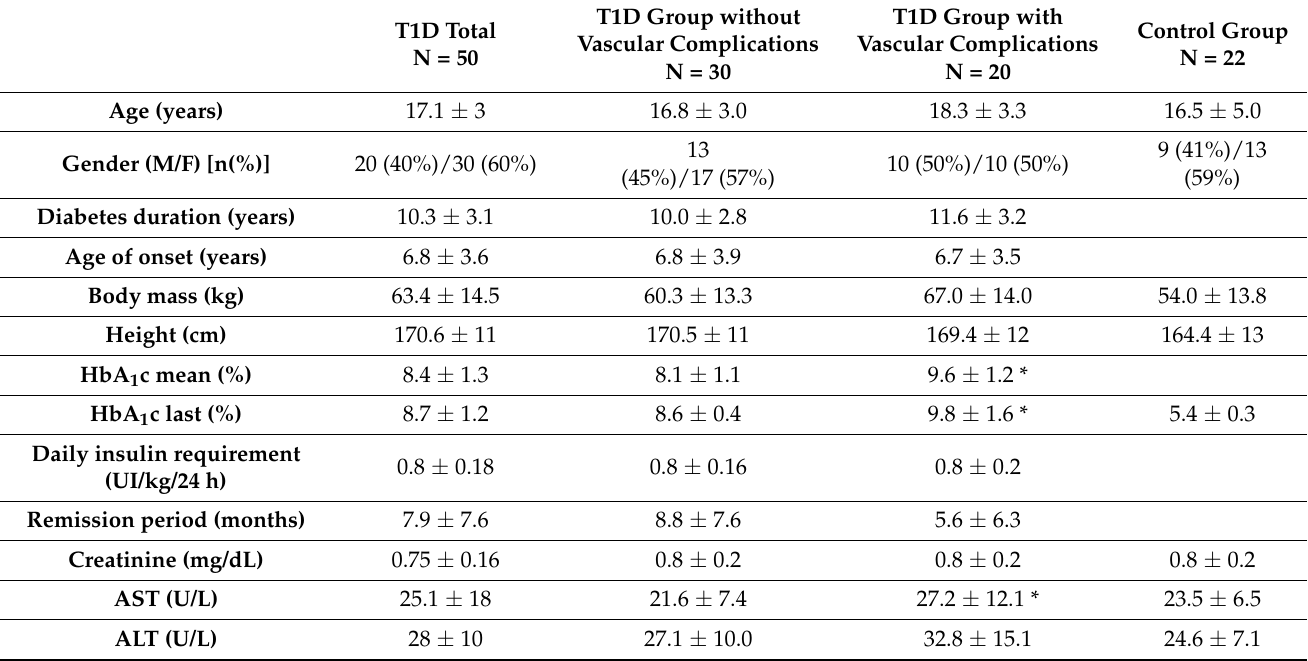
Table 1. General characteristics of the study groups.